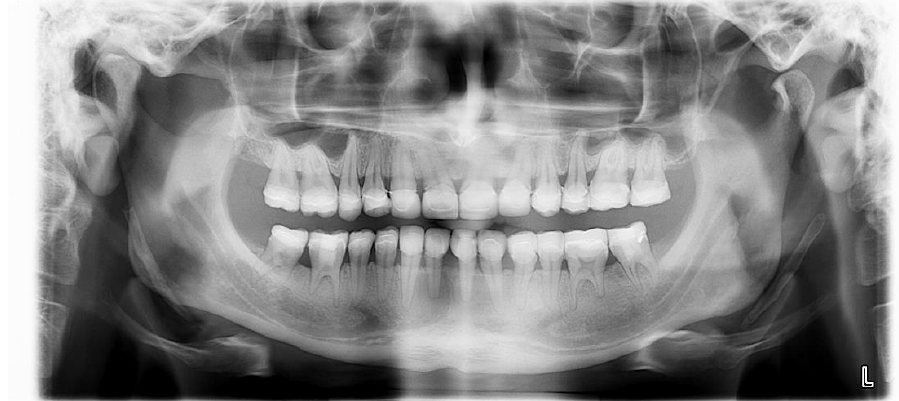
Figure 16. Orthopantomogram of the patient at 8 months after the end of the dental treatment.